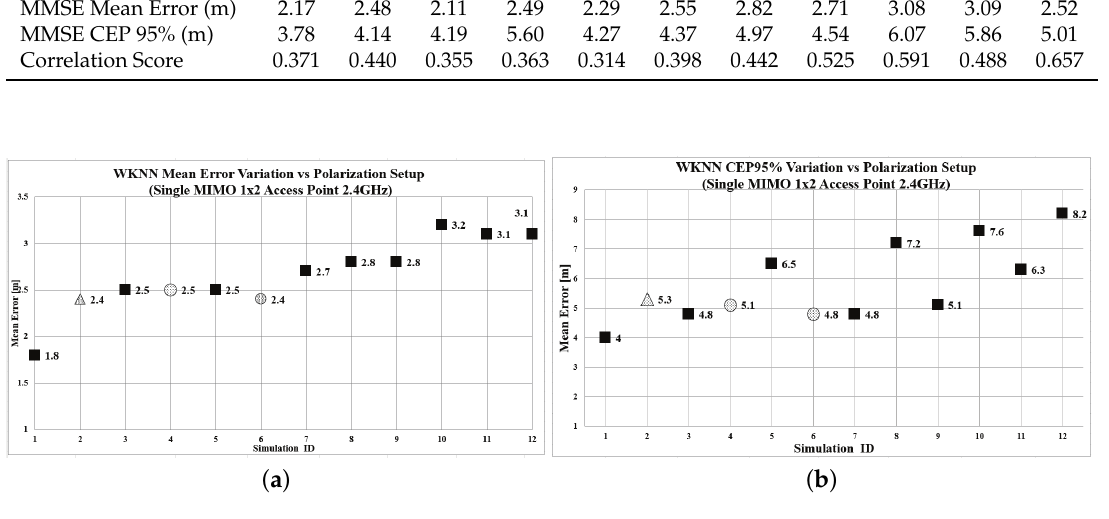
Figure 6. WKNN Algorithm performance. ( a ) Mean error per polarization Scenario; ( b ) CEP95 per polarization